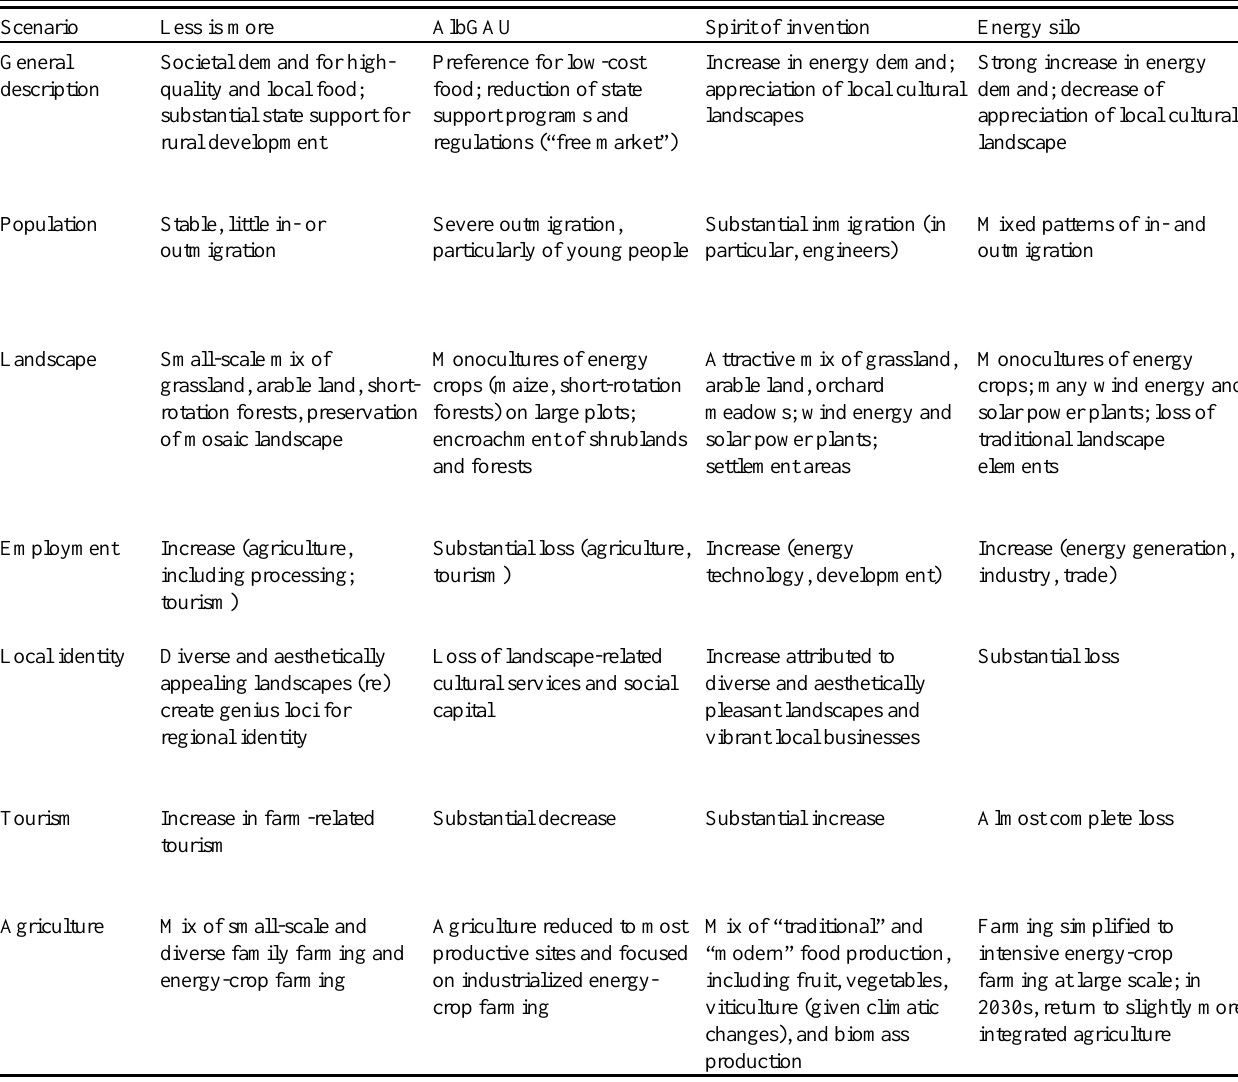
Table 1 . Key features of the scenario